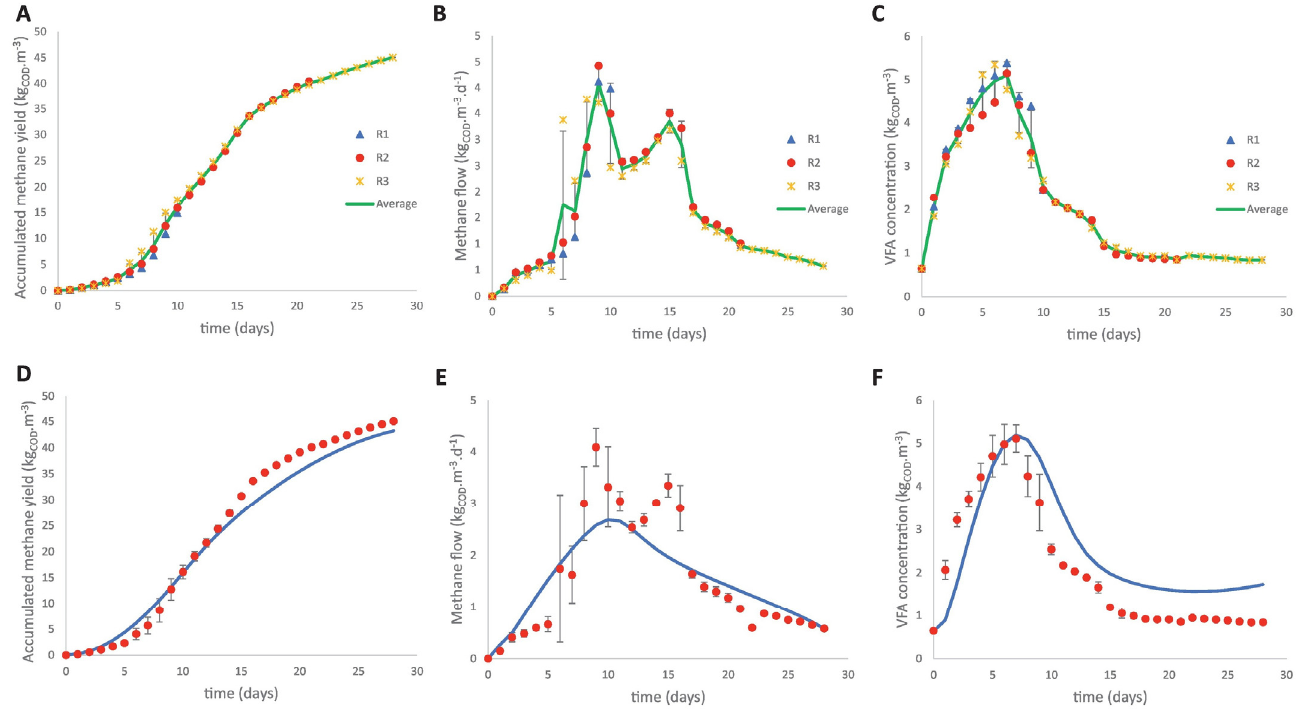
Figure 4. Experimental and simulated data from the Mobile-Immobile model, ( A ) experimental accumulated methane yield, ( B ) experimental methane flow, ( C ) experimental VFA evolution. Corre- sponding simulated data are shown in blue curves and mean experimental data are shown in red symbols in ( D – F ). Figure reprinted from Coutu et al. (2022) [66], Copyright (2023), with permission from Elsevier.